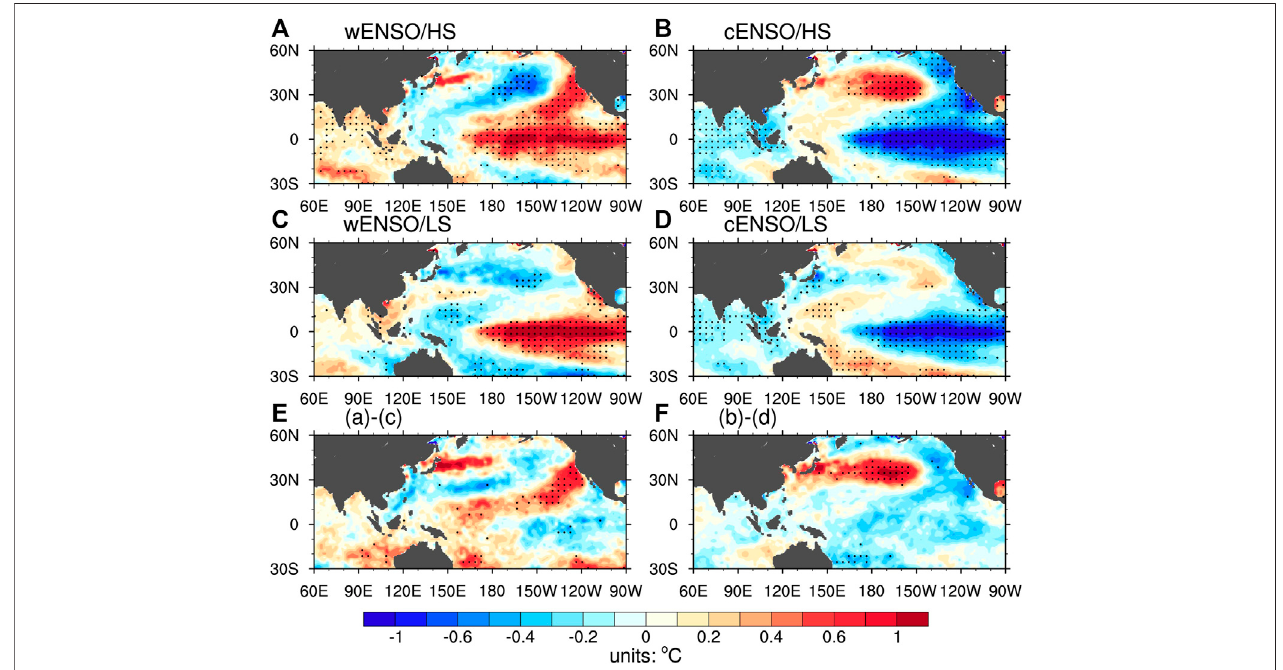
FIGURE 9 | Same as Figure 4 , but for composites of SST anomaly (shaded, unit: ° C). Solid dots denote 95% con fi dence level for SST.